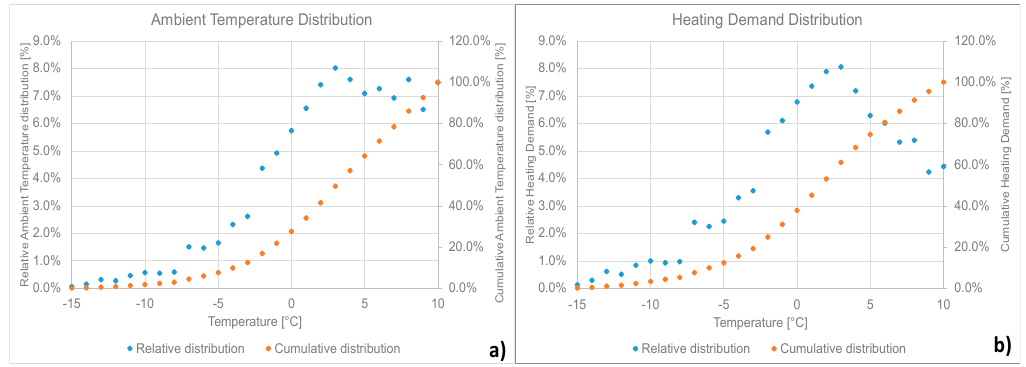
Figure 7. Ambient temperature distribution for the heating season in Regensburg ( a ) and heating demand derived from the climatic analysis ( b ).